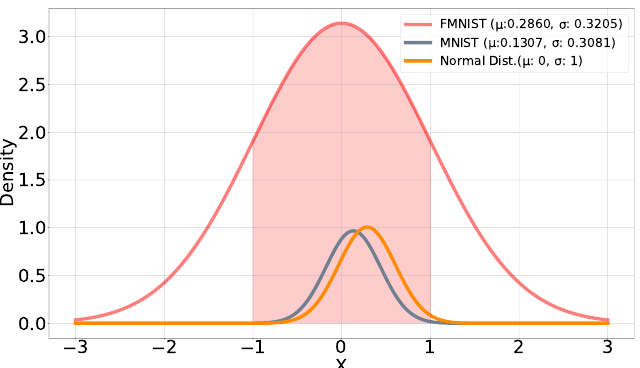
Figure 5. Standardized pixel values lie within the one σ of a normal distribution centered at µ =